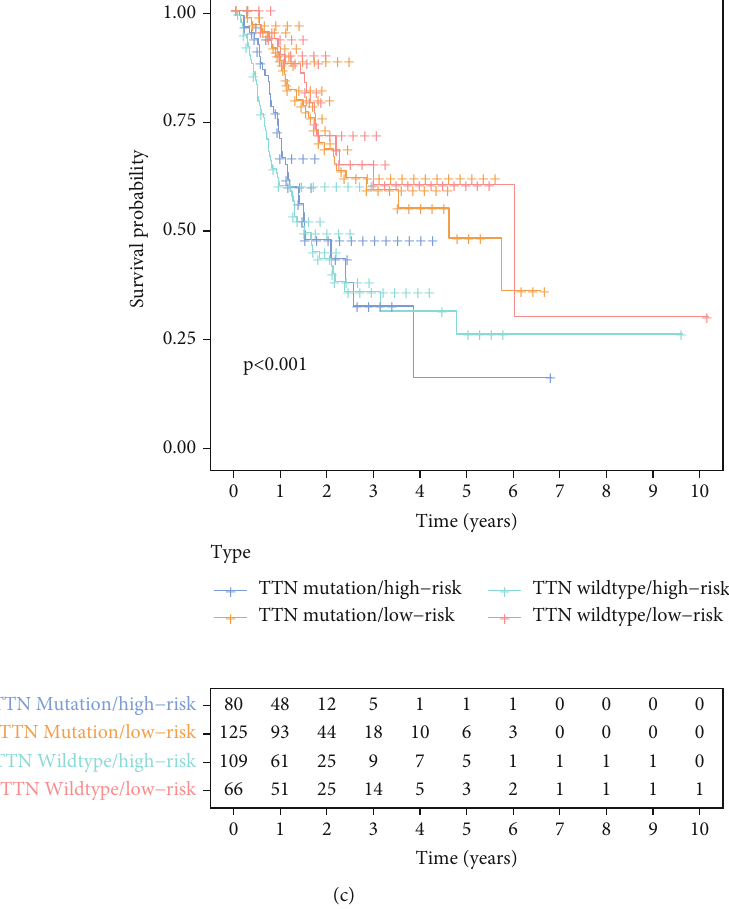
Figure 7: Relationship between the GIMiSig and TTN mutation status. (a) Overview of gene mutations in GC patients from TCGA. (b) Distribution of wild and mutated TTN in the high- and low-risk groups in the training, testing, and whole sets. (c) Survival curves for patients strati fi ed by TTN mutation status and